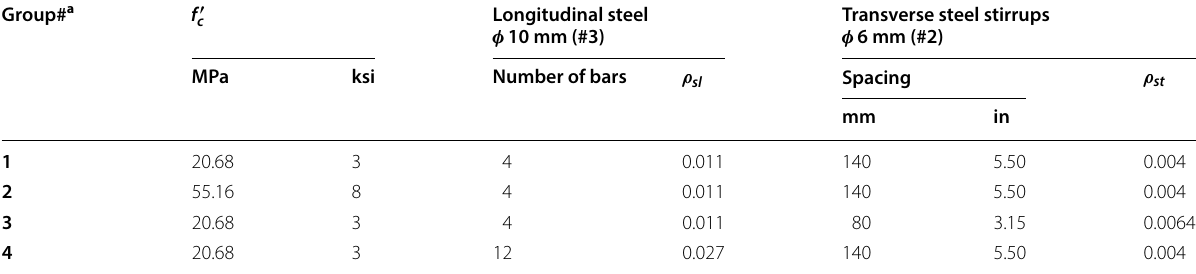
Table 2 Column groups used in the parametric